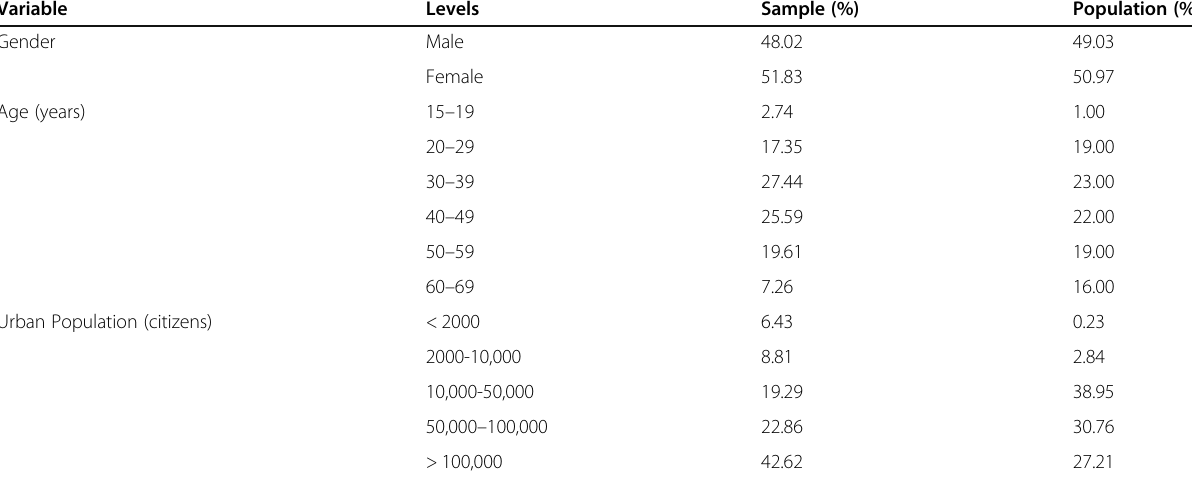
Table 2 Sample composition and